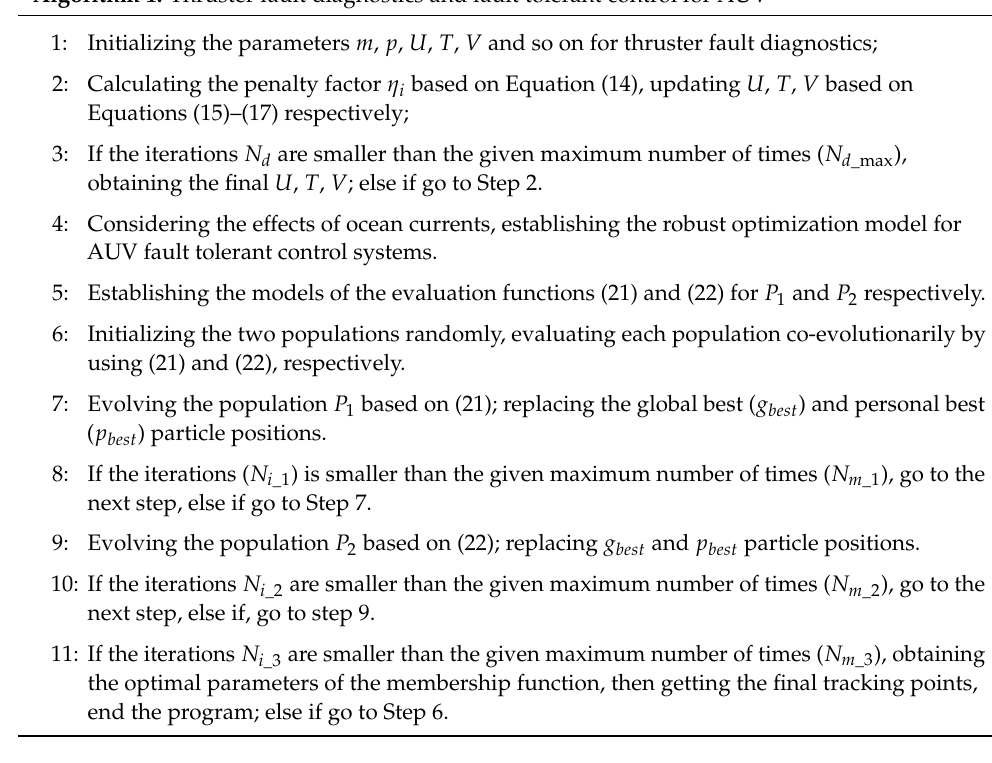
Algorithm 1: Thruster fault diagnostics and fault tolerant control for